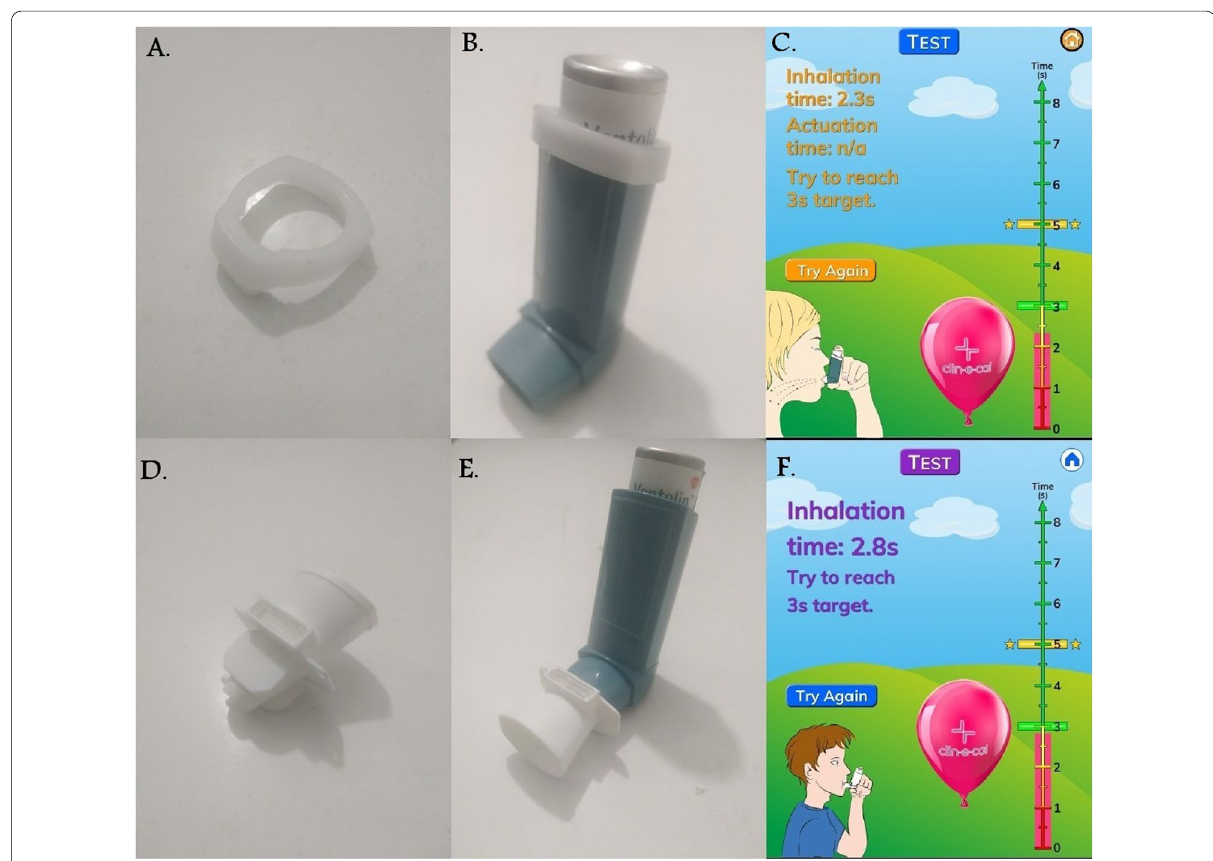
Fig. 2 Clip-Tone and Flo-Tone training devices with their respective smartphone applications. A Clip-Tone device B Clip-tone placement on pMDI C “Clip-Tone Buddy” smartphone application (in-application screenshot). D Flo-Tone Device E Flo-Tone placement on pMDI F “Trainhaler Buddy”,